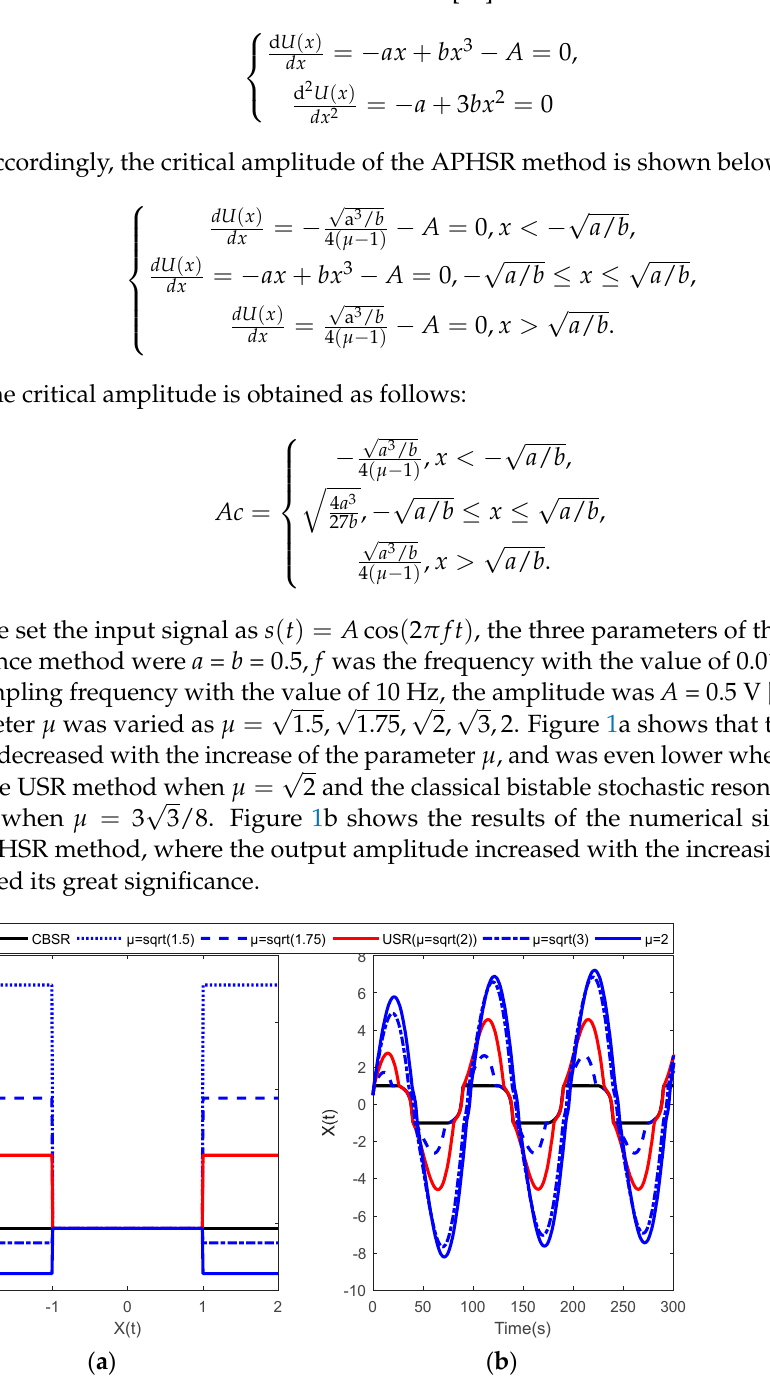
Figure 1. Critical amplitudes and outputs via three different methods with parameter μ .